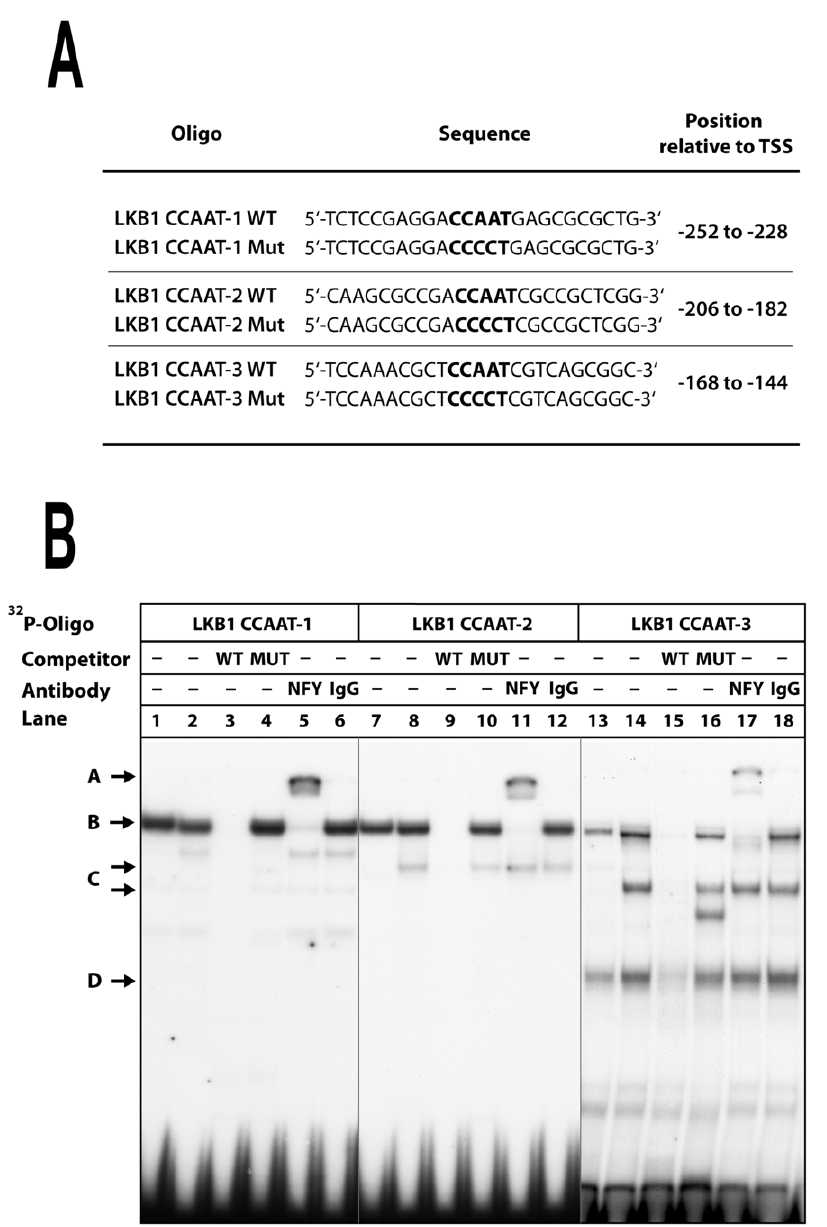
Figure 4. Binding of NF-Y transcription factor to CCAAT boxes within the LKB1 promoter. 32 P-labeled double-stranded oligonucleotides harbouring the CCAAT boxes (their positions relative to the transcriptional start site, TSS, are indicated) ( A ) were incubated with 2 m g of nuclear extracts from ‘‘444’’ cells (lanes 1, 7 and 13) or from HepG2 cells (lanes 2–6, 8–12, and 14–18) and separated in a 7% polyacrylamide gel ( B ). Formation of sequence specific protein complexes was confirmed by competition with unlabeled oligos. Specific bands (indicated by arrows B, C and D) were competed by a 500-fold molar excess of wild-type oligo (WT; lanes 3, 9 and 15) but not by the same excess of mutant oligo (MUT; lanes 4, 10 and 16, respectively). Protein complexes containing the transcription factor NF-Y (arrow A) were further retarded by addition of an antibody against NF-Y a (NFY; lanes 5, 11 and 17) but not by the addition of the same amount of normal goat IgG (IgG; lanes 6, 12 and 18).